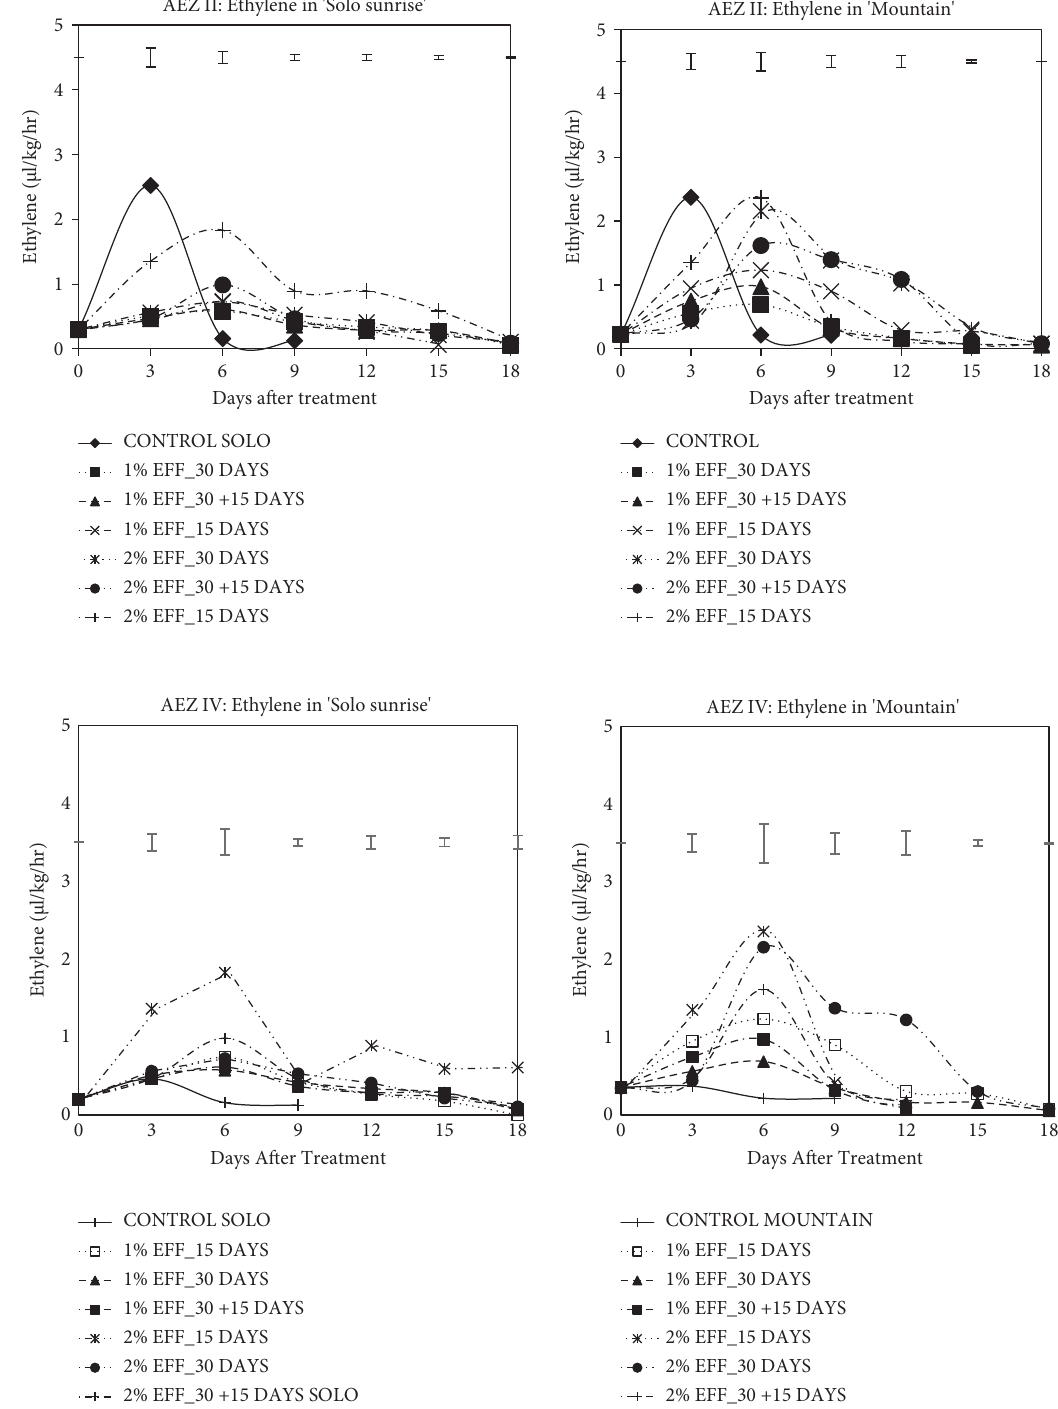
Figure 6: The rate of ethylene evolution from ripening papaya fruits treated with Hexanal spray from Machakos and Meru counties. Top bars represent LSD at